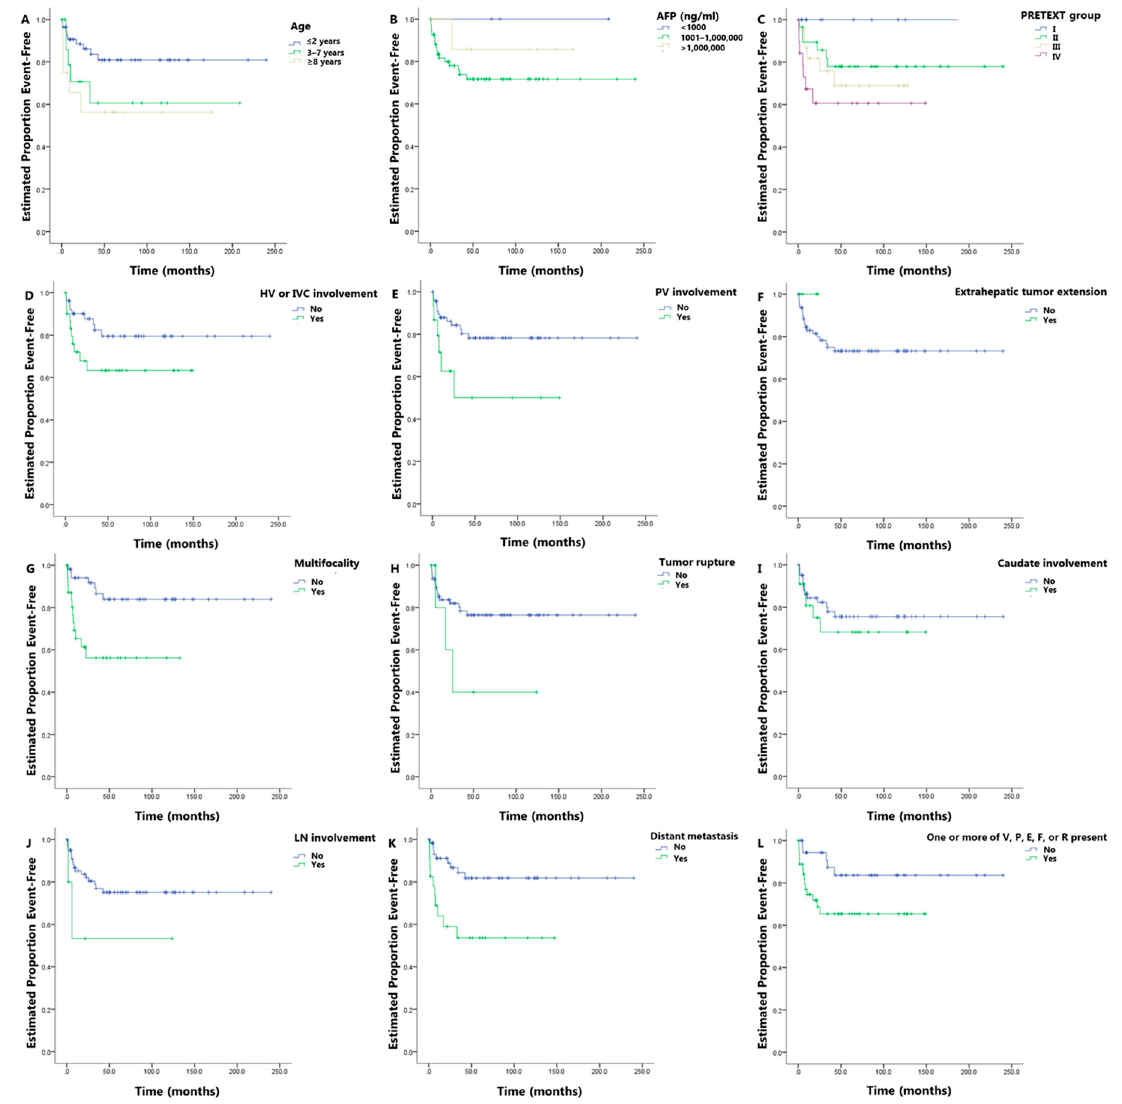
Figure 2. Kaplan–Meier curves of event-free survival (EFS) according to age ( A ), serum alpha-fetoprotein (AFP) levels at initial presentation ( B ), PRETEXT group ( C ), HV or IVC involvement ( D ), portal vein involvement ( E ), extrahepatic tumor extension ( F ), multifocality ( G ), tumor rupture ( H ), caudate involvement ( I ), lymph node involvement ( J ), distant metastasis ( K ), and presence of one or more of VPEFR ( L ). The detailed information for each graph is described in the supplementary figure legend.